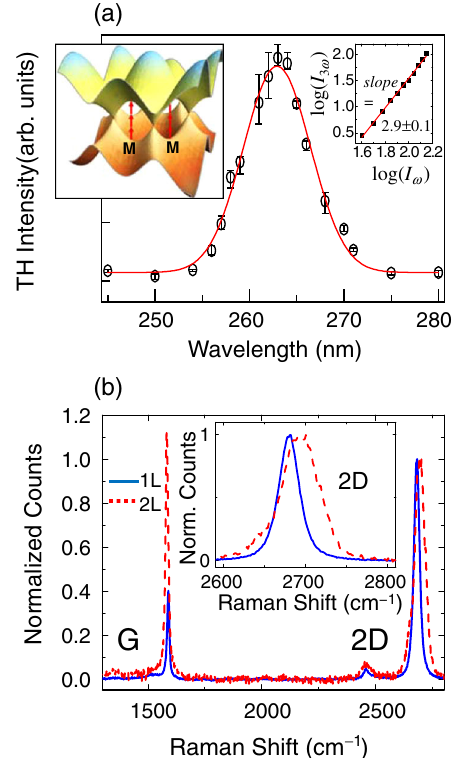
FIG. 2. (a) THG spectrum along with a right inset log-log plot showing a cubic power dependence of the TH signal intensity I with respect to the intensity of the fundamental beam, I ! . 3 ! The left inset shows the electronic band structure of graphene, including a three-photon resonance at the exciton-shifted gra- phene M saddle point. (b) The Raman spectra in the monolayer (1L) and bilayer (2L) regions of the graphene flakes (solid and dashed curves, respectively). The Raman signals are normalized with respect to the 2D